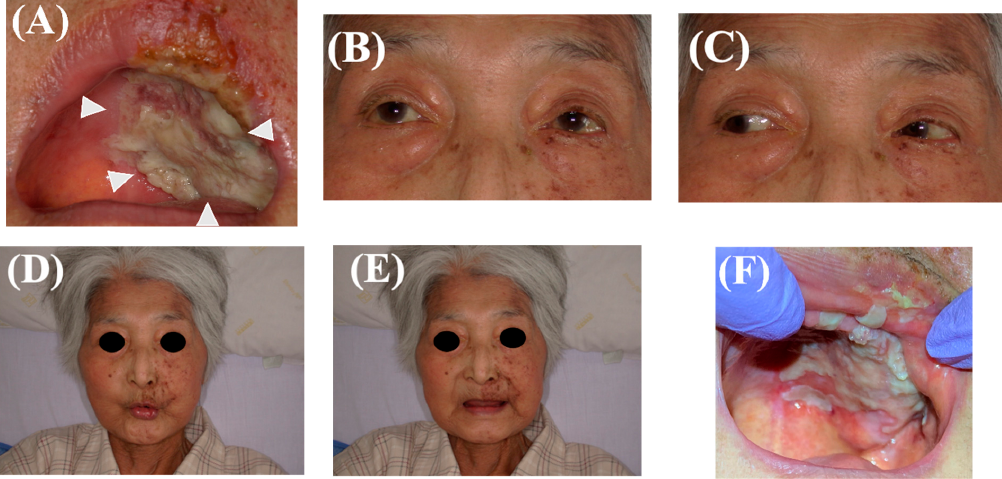
Figure 1. ( A ) Ulcers of the oral cavity and lips, and extensive spread of herpes to the buccal skin. Photograph of facial appearance and oral cavity at the initial visit. ( B ) No ocular symptoms (kerati- tis, iris ciliary inflammation, scleritis) due to herpes zoster virus infection in the region of the first branch (V1) of the trigeminal nerve. ( C ) No eye movement disorders. ( D ) No abnormal findings in facial nerves that move facial muscles to purse mouth, pull lips, ( E ) raise eyebrows, etc. ( F ) Photograph of facial appearance and oral cavity 6 days later.